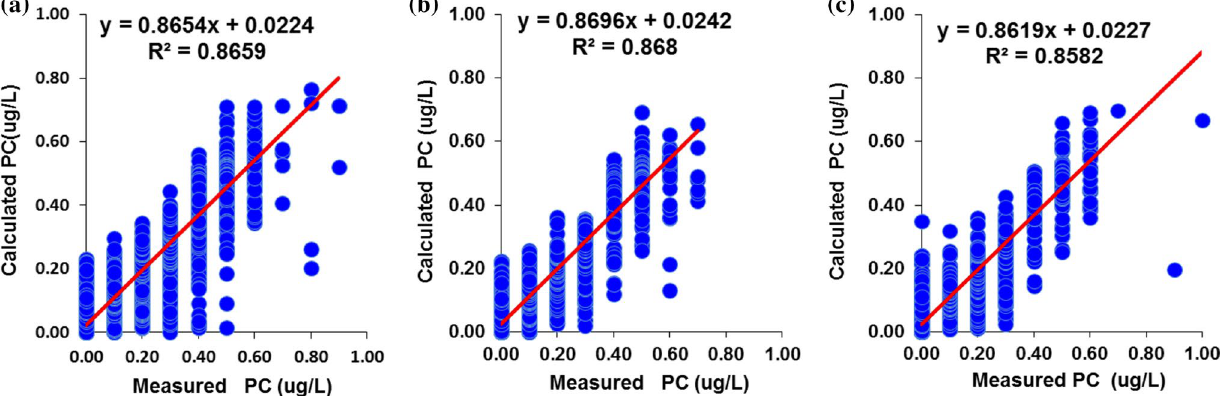
Fig. 8 Scatterplots of estimated versus measured values of PC for ANFIS_GP (M1) model: a training, b validation and c test data—station ID: